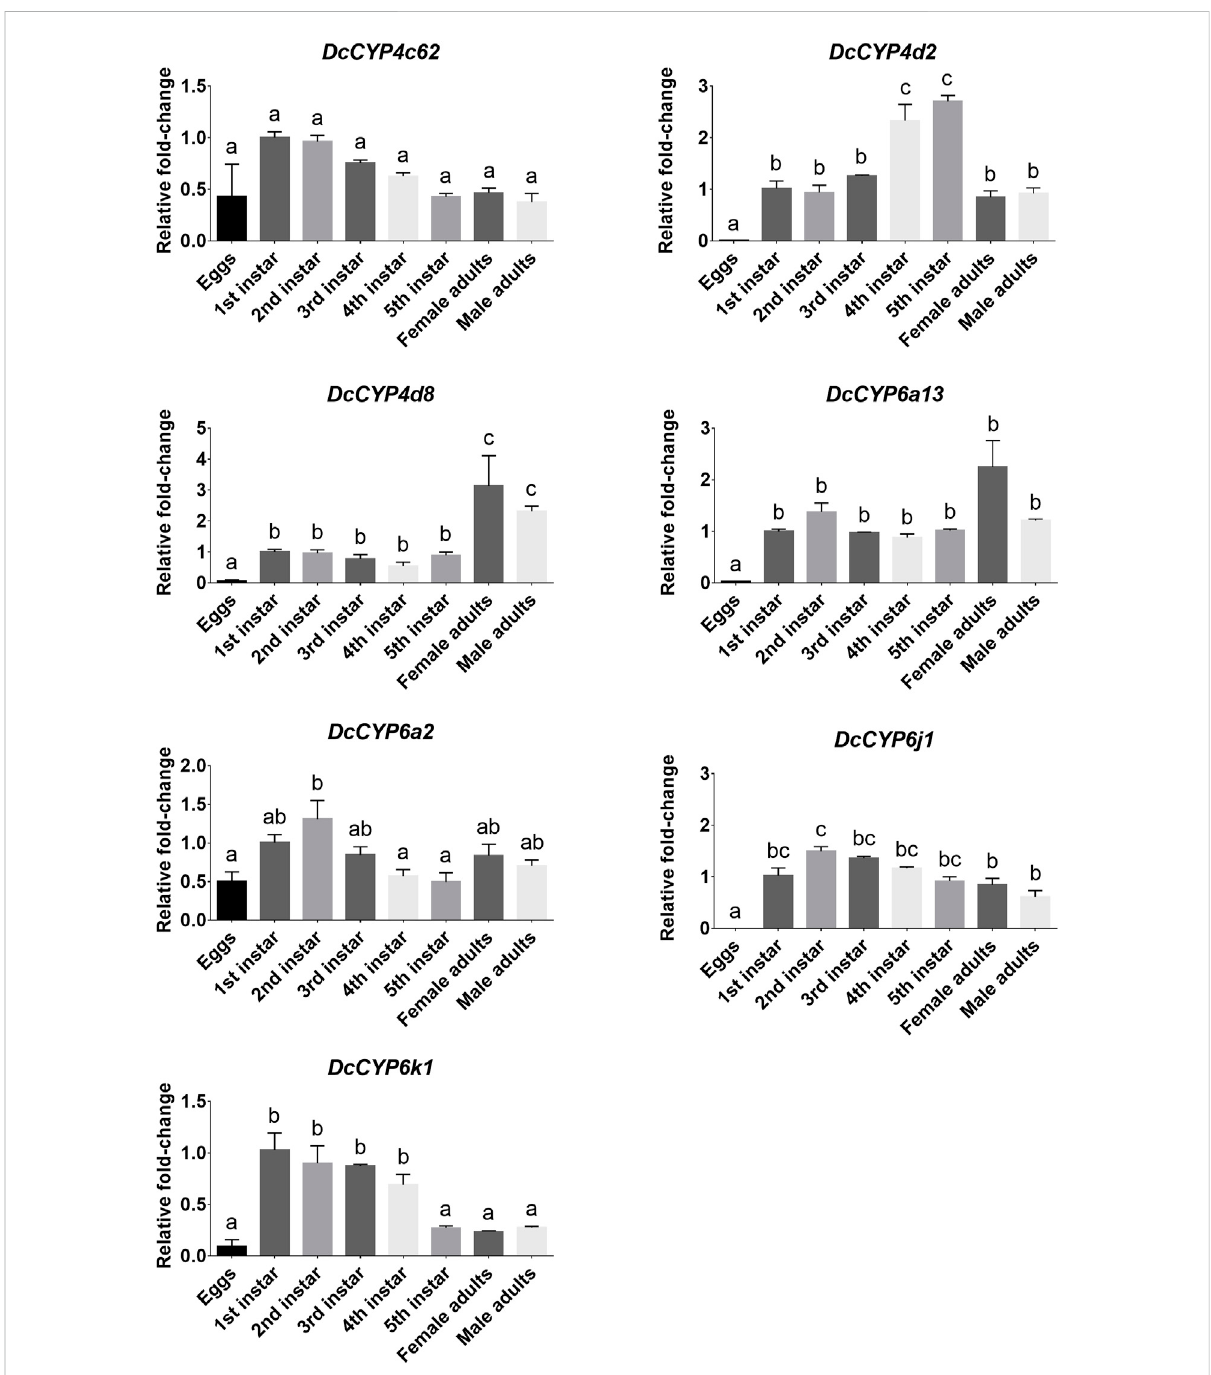
FIGURE 5 DcCYP expression at different life stages of D. citri . The expression level of DcCYP in fi rst instar nymph was assigned an arbitrary value of 1. The expression levels in other samples are presented relative to the average fi rst instar levels. Error bars represent standard error. Different letters above the error bar indicate signi fi cant differences among developmental stages ( p < 0.05; one-way ANOVA, Tukey ’ s multiple comparisons